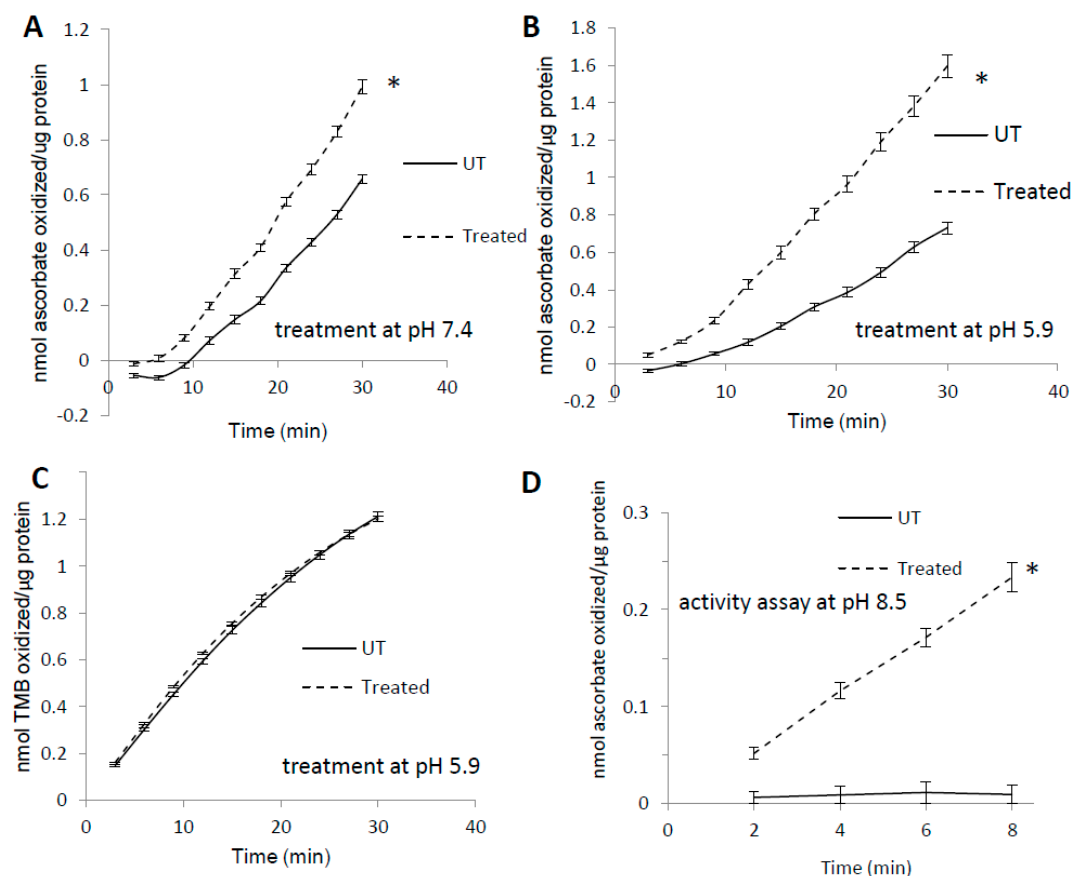
Figure 1. Pre-treatment with H 2 O 2 increases MetMb peroxidase activity in a substrate-dependent manner. MetMb (111 µ M, pH 5.9) was untreated (UT) or was pre-reacted with 50 µ M H 2 O 2 for manner. MetMb (111 µM, pH 5.9) was untreated (UT) or was pre-reacted with 50 µM H 2 O 2 for 15 min at ( A ) pH 7.4 ( n = 12/group, * p < 0.05) and ( B ) pH 5.9 ( n = 7/group, * p < 0.05) before 2 µL of this solution